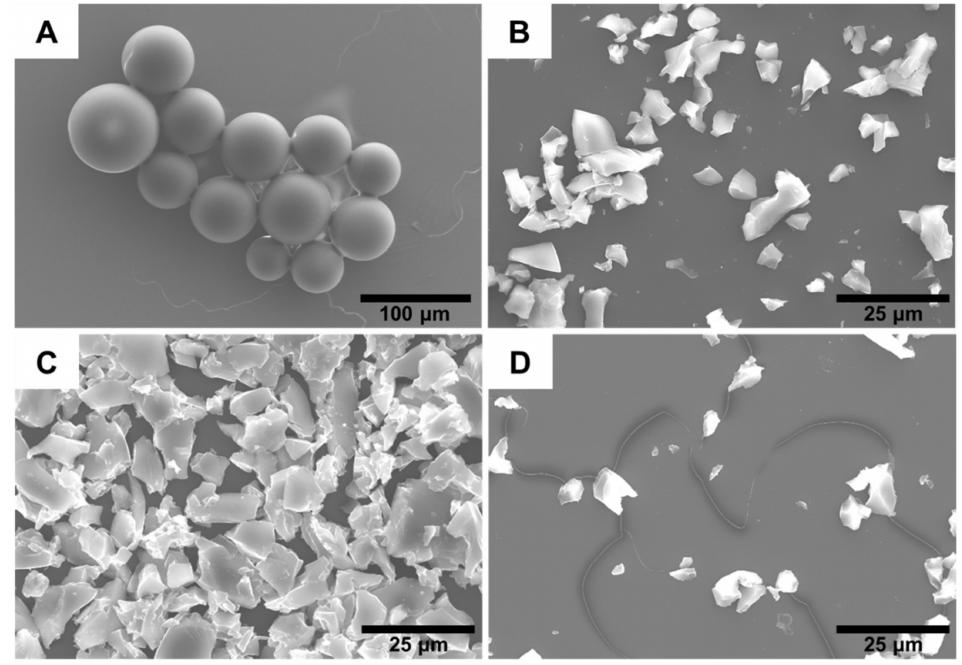
Figure 4. SEM images of ( A ) MF, ( B ) MF-Py + , ( C ) NCTPP-MF, and ( D ) NCTPP-MF-Py +